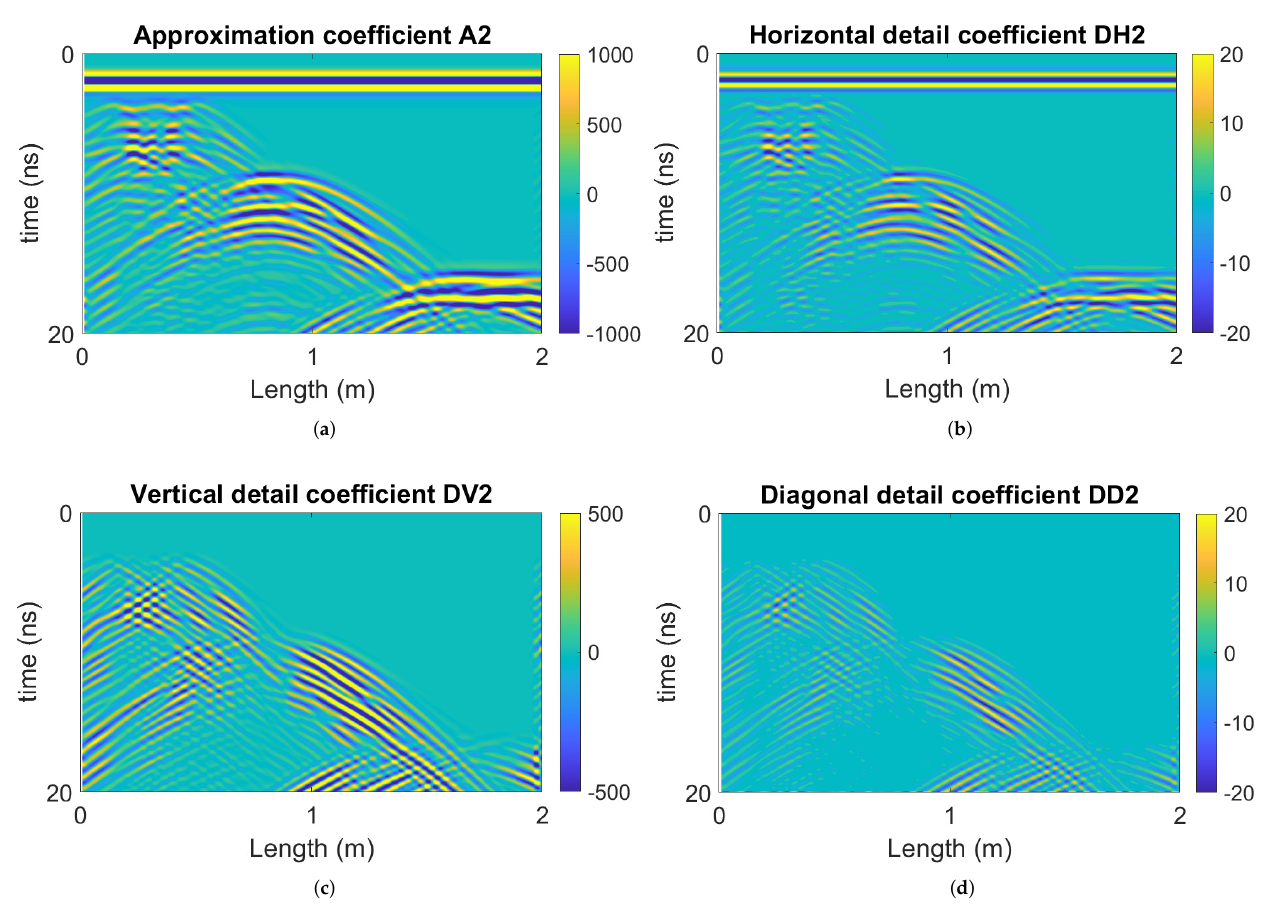
Figure 11. 2nd layer ( a ) approximation coefficient A 2 , ( b ) horizontal detail coefficient DH 2 , ( c ) vertical detail coefficient DV 2 , and ( d ) diagonal detail coefficient DD 2 from 2D SWT on Figure